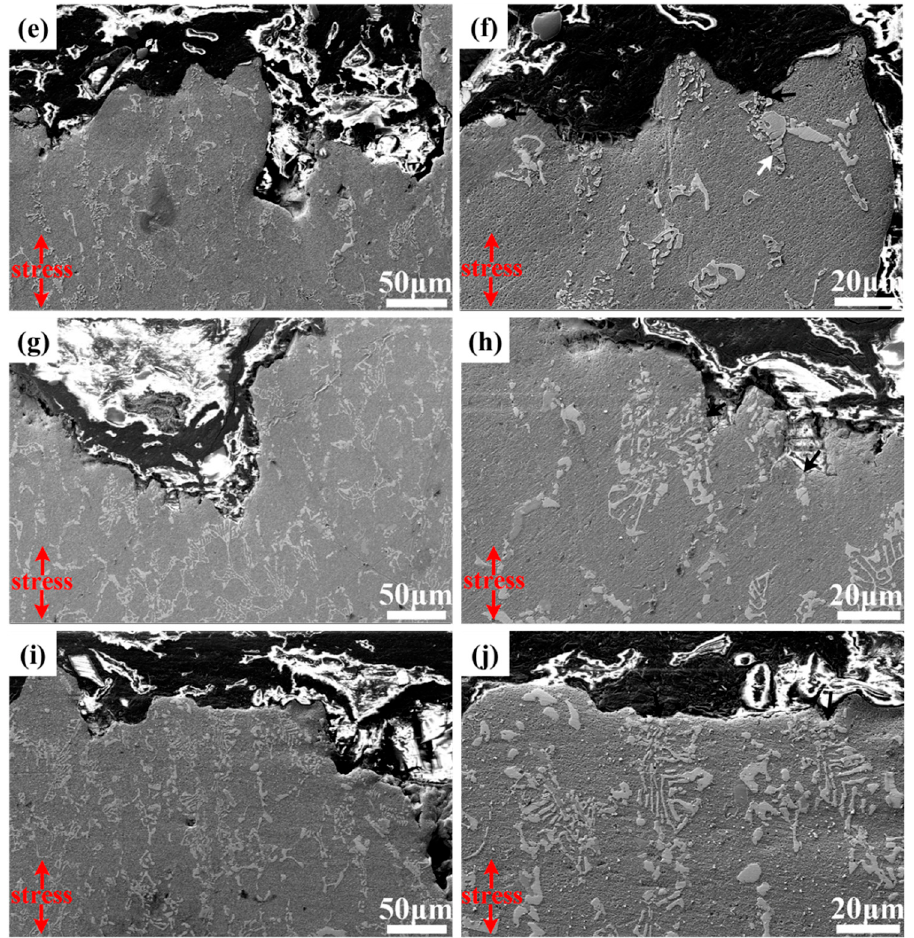
Figure 9. SEM microstructure beneath the fracture surfaces of the tensile specimens of heat-treated alloys tested at 400 °C: ( a , b ) 0 Ni alloy, ( c , d ) 0.5 Ni alloy, ( e , f ) 1.0 Ni alloy, ( g , h ) 2.0 Ni alloy, ( i , j ) 4.0 Ni alloy, ( b , d , f , h , j ) magnified pictures of ( a , c , e , g , i ), respectively. The black arrows indicate the torn intermetallic phases.